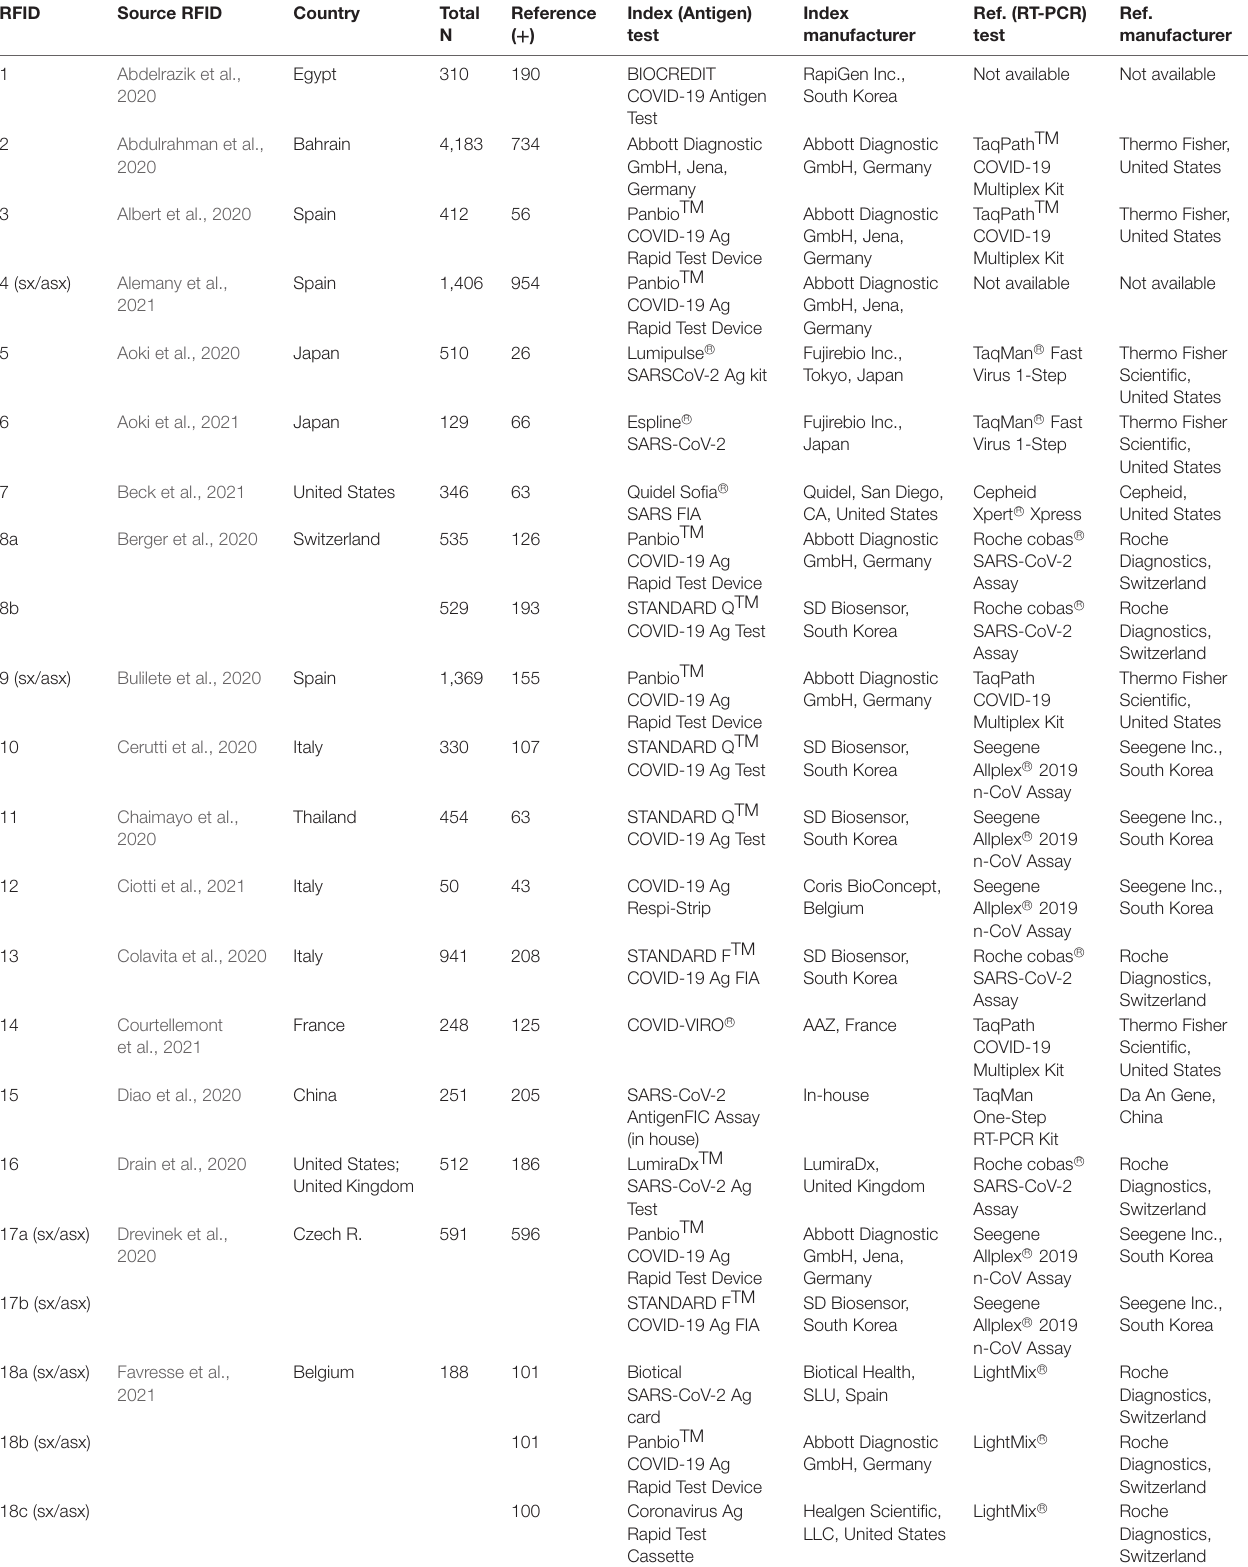
TABLE 1 | Information characterizing data sources involving SARS-CoV-2 antigen testing for analyses described in this report. RFID Source RFID